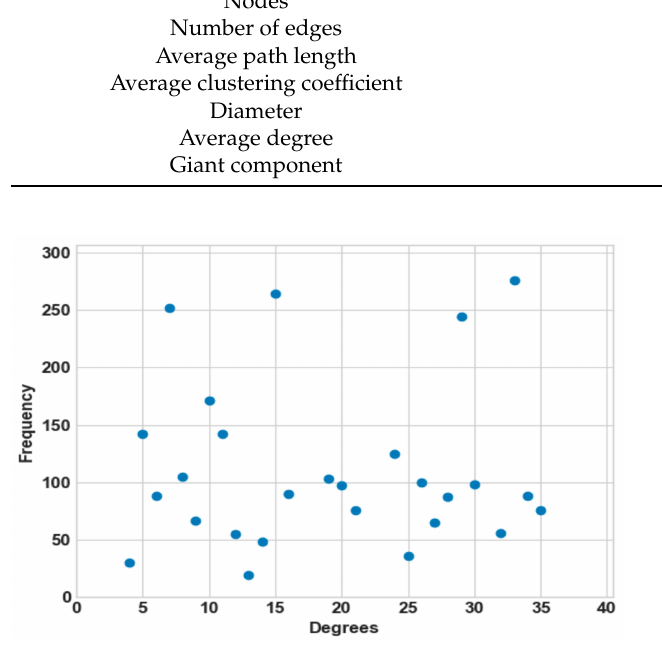
Figure 4. Degree distribution of the initial